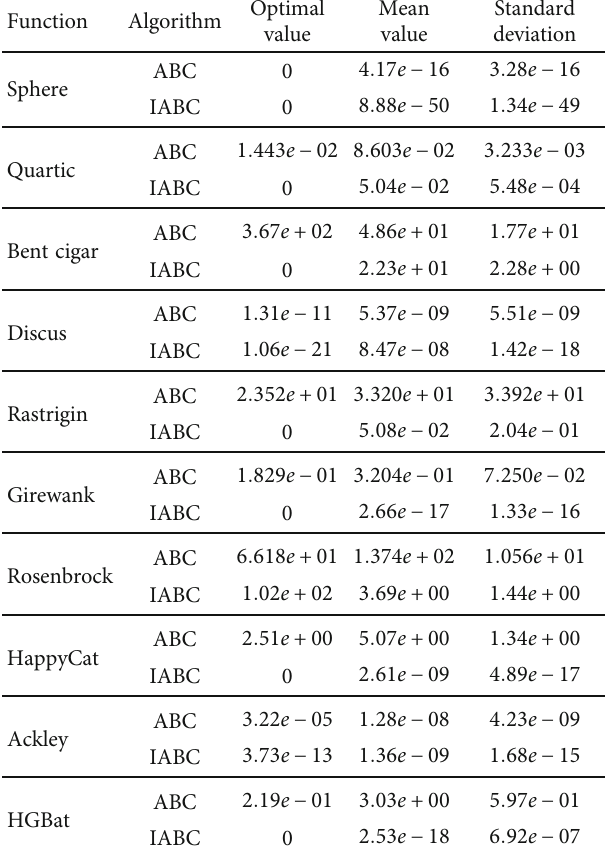
Table 3: Performance comparison of ABC algorithm and IABC algorithm in 30-dimensional space. Function Algorithm